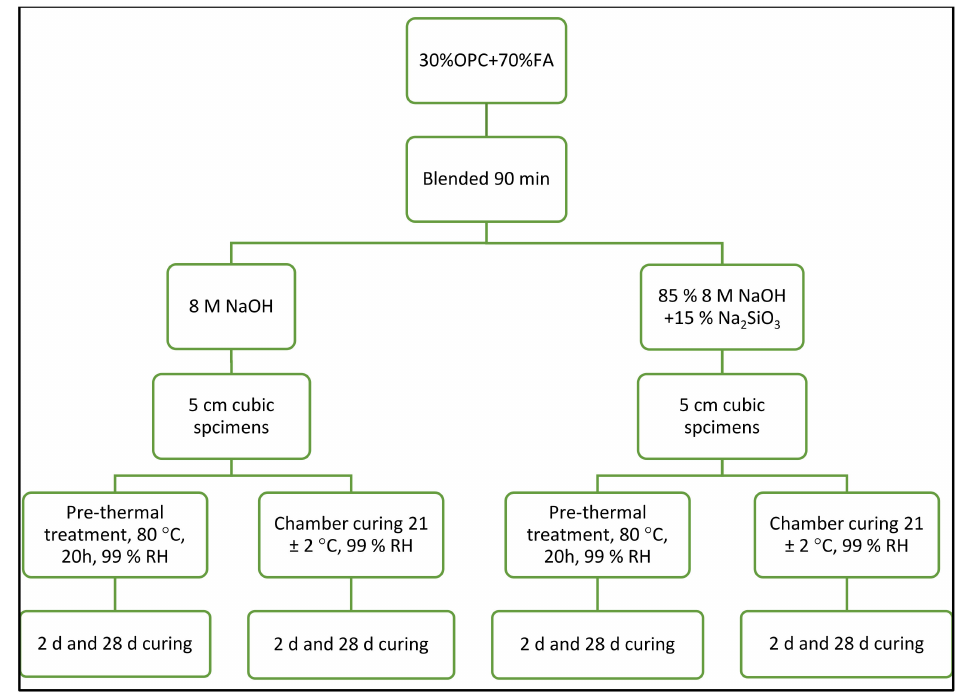
Figure 2. Flowchart for procedure followed and variables used to prepare hybrid cement paste specimens. Table 4. Nomenclature for hybrid cement pastes and variables considered in their